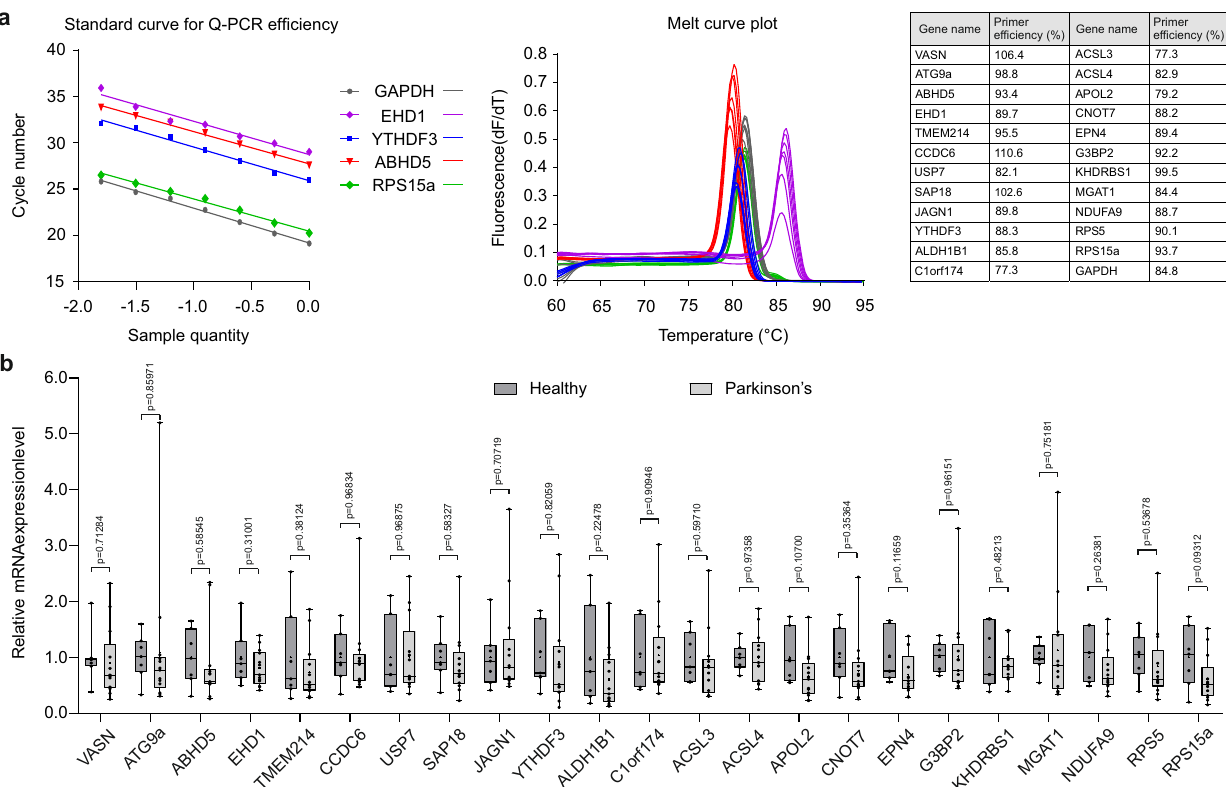
Fig. 6 mRNA levels of translationally repressed proteins do not change in sporadic patient fi broblasts. a Sample standard curves for primer ef fi ciencies are shown including a table of all primer ef fi ciencies. All primer pairs ampli fi ed a product with a single melting temperature peak, con fi rming the ampli fi cation of a single speci fi c product (representative data shown). Resulting primer ef fi ciencies were all in the range of 75 – 110% qPCR reaction ef fi ciency. b The relative expression of mRNA was measured for the 23 genes, the protein counterparts of which signi fi cantly changed in PD patients with an FDR < 0.05 in either ROTS or t -test. GAPDH was included as a housekeeping gene. Whiskers extend from the smallest to the largest values, with a box depicting 50% of middle values from bottom 25% to top 75% and line shows the median. Two-tailed Student ’ s t -test did not reveal signi fi cant changes in the gene expression among patient versus healthy in any of the